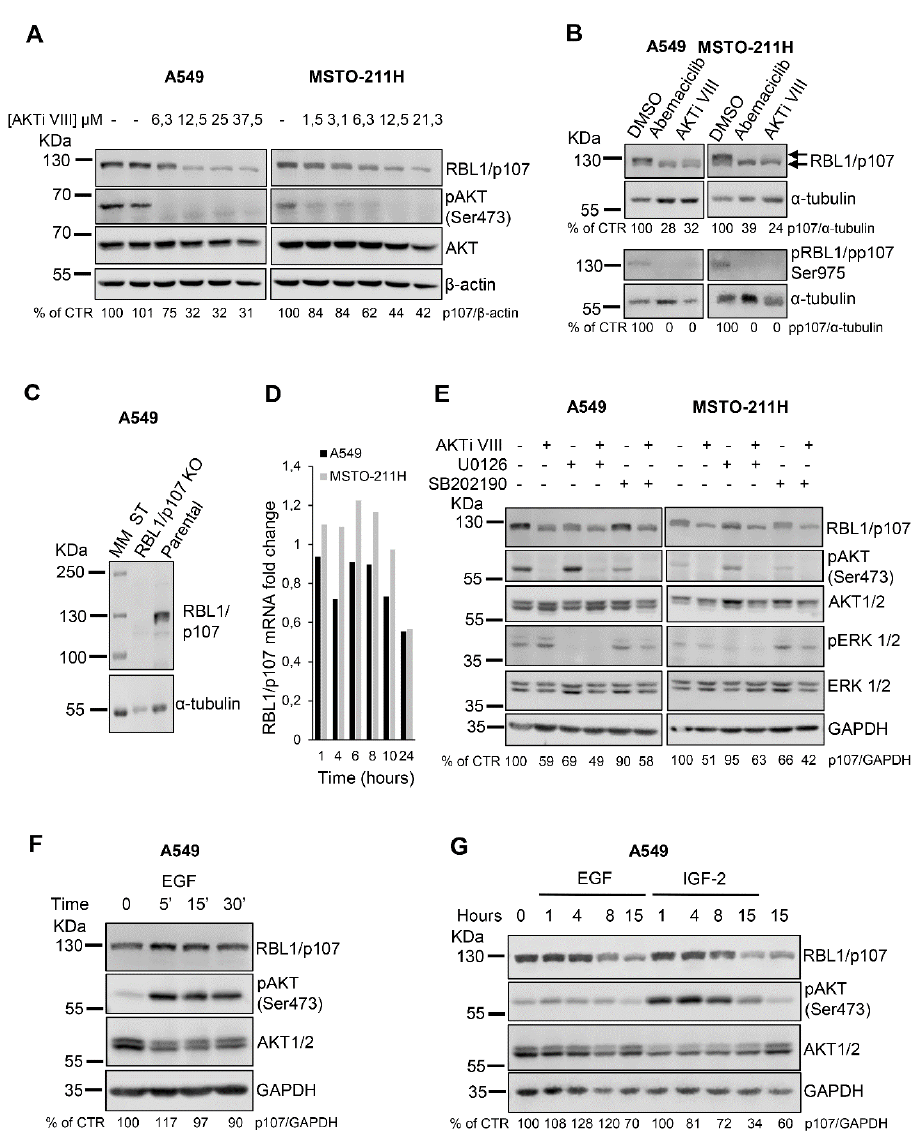
Figure 1. The AKT inhibitor AKTi VIII reduces RBL1/p107 levels in A549 and MSTO-211H cells. ( A ). A549 and MSTO-211H cells were treated with the indicated concentrations of the AKT inhibitor AKTi VIII for 16 h. RBL1/p107 levels were analyzed in cell lysates by immunoblot. ( B ). A549 and MSTO-211H cells were treated with 0.2 µM Abemaciclib or 12.5 µM AKTi VIII for 16 h. Levels of total and phosphorylated p107 (ser975) were analyzed by immunoblot. Arrows indicate the two major bands corresponding to hyper- and hypo-phosphorylated RBL1/p107. ( C ). RBL1/p107 levels were analyzed in cell lysates of parental and A549 cells with RBL1/p107 knock-out by CRISPR/Cas9. MM: molecular mass. ( D ). RBL1/p107 mRNA levels were determined by RT-PCR in A549 and MSTO-211H cells treated with 12.5 µM AKTi VIII for the indicated time points. ( E ). RBL1/p107 levels were determined by immunoblot in A549 and MSTO-211H cells preincubated with the MEK1/2 inhibitor U0126 or the p38 inhibitor SB202190, at the concentration of 10 and 20 µM, respectively, for 2 h and then treated with the same concentrations of U0126 or SB202190 alone or in combination with 12.5 µM AKTi VIII for 16 h ( F ). A549 cells were treated with 50 ng/mL EGF for the indicated time and RBL1/p107 protein levels analyzed by immunoblot. ( G ). RBL1/p107 levels were analyzed in cell lysates of A549 cells treated for the indicated time with 50 ng/mL EGF or 10 nM IGF-2. Western blot quantification was performed using the ImageJ program, normalized to β -actin, α -tubulin or GAPDH expression and reported as % of control (CTR). All experiments were performed three